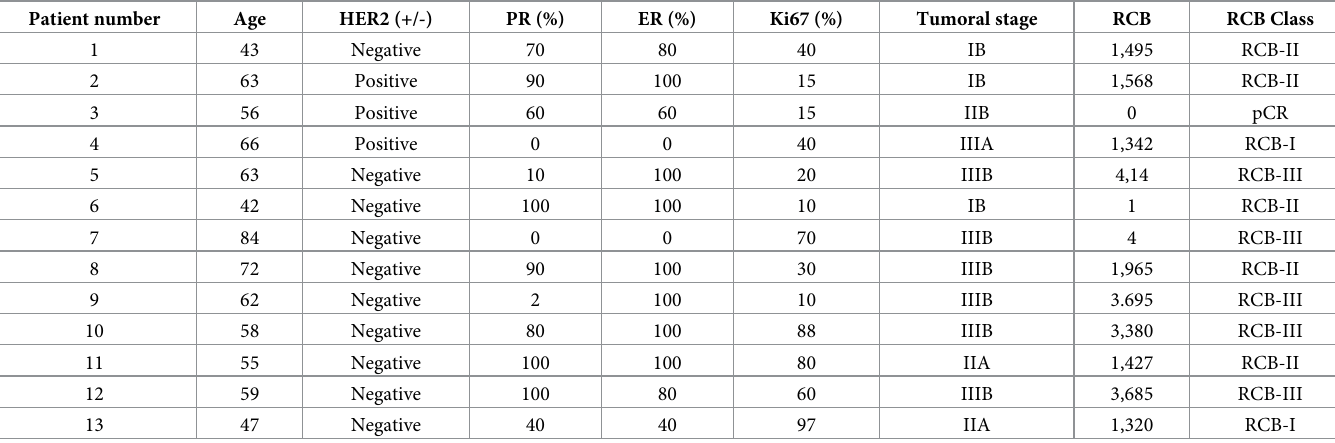
Table 1. Patients’ clinical characteristics.